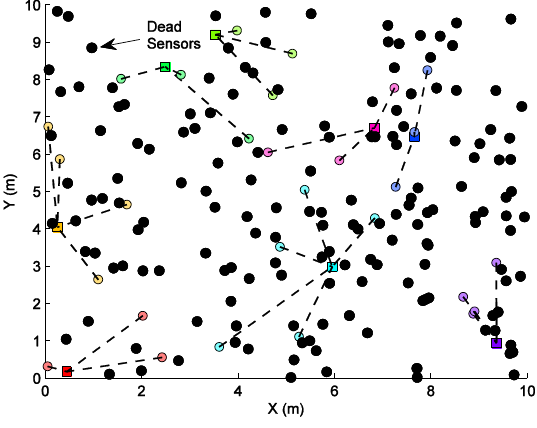
Figure 12. Last output of proposed method.